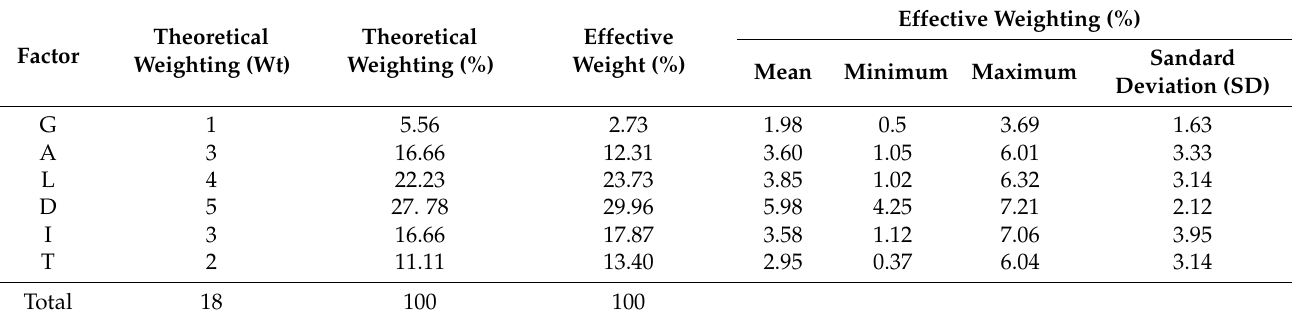
Table 6. Statistical summaries of SPSA of GALDIT